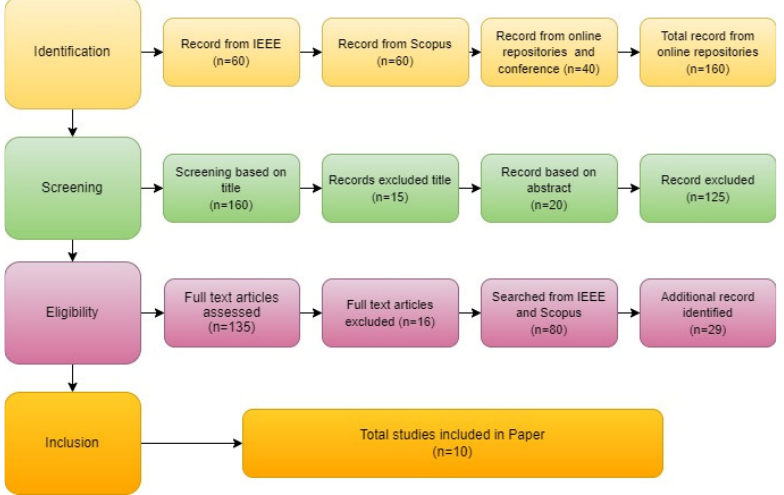
Figure 3. Research collection